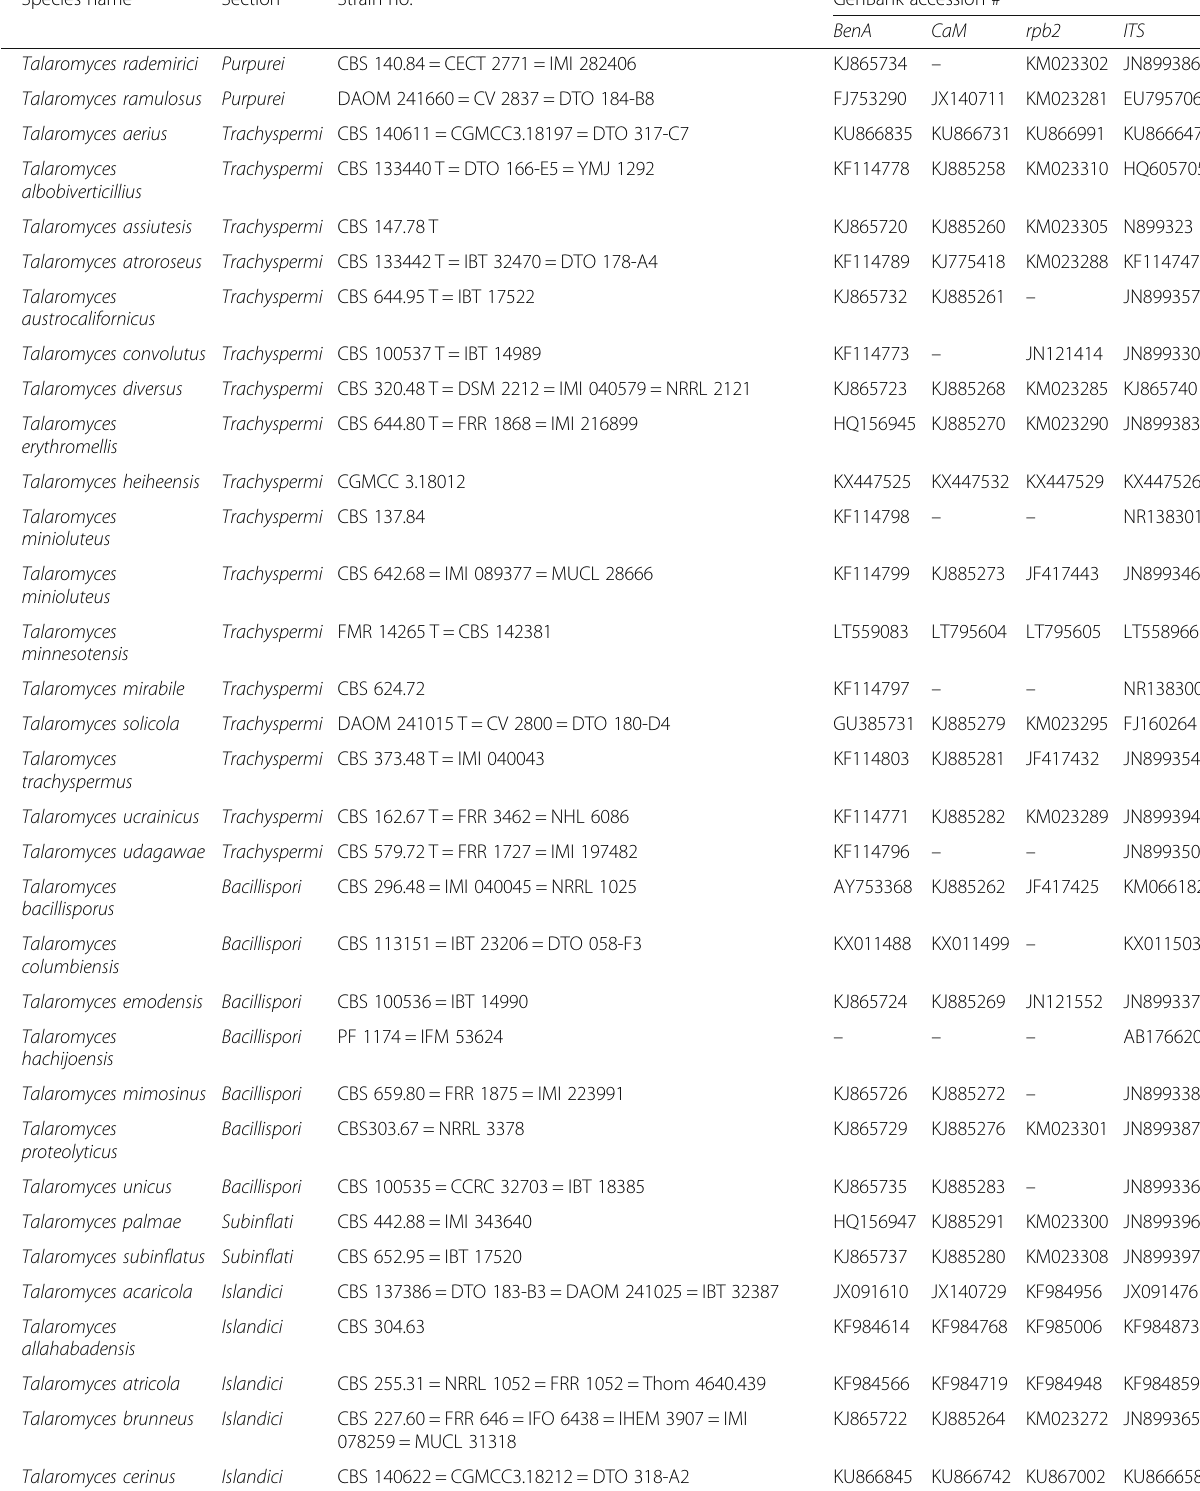
Table 2 Talaromyces spp. nucleotide sequences employed to build a phylogram to locate phylogenetically our strains from honey